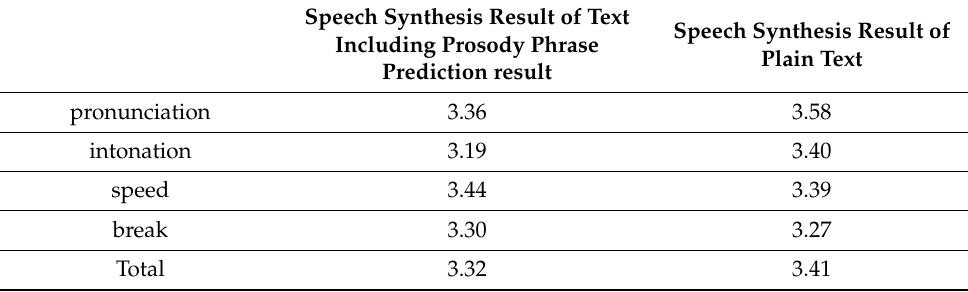
Table 13. Comparison of MOS evaluation